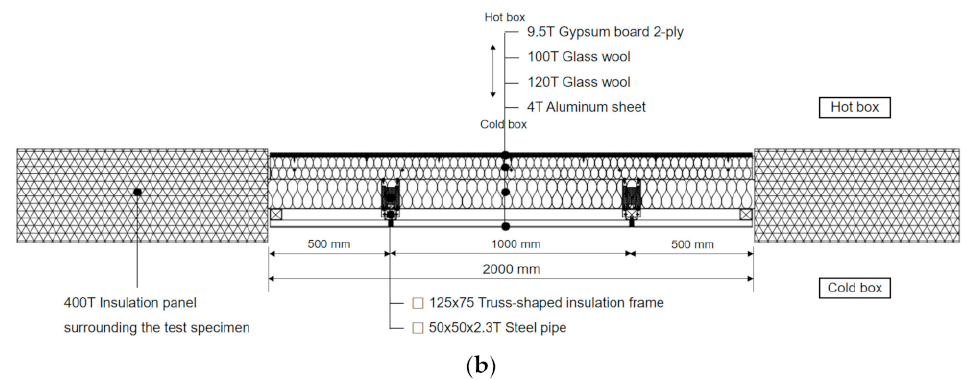
Figure 11. Horizontal sections of mock-ups: ( a ) base case; ( b ) alternative case.